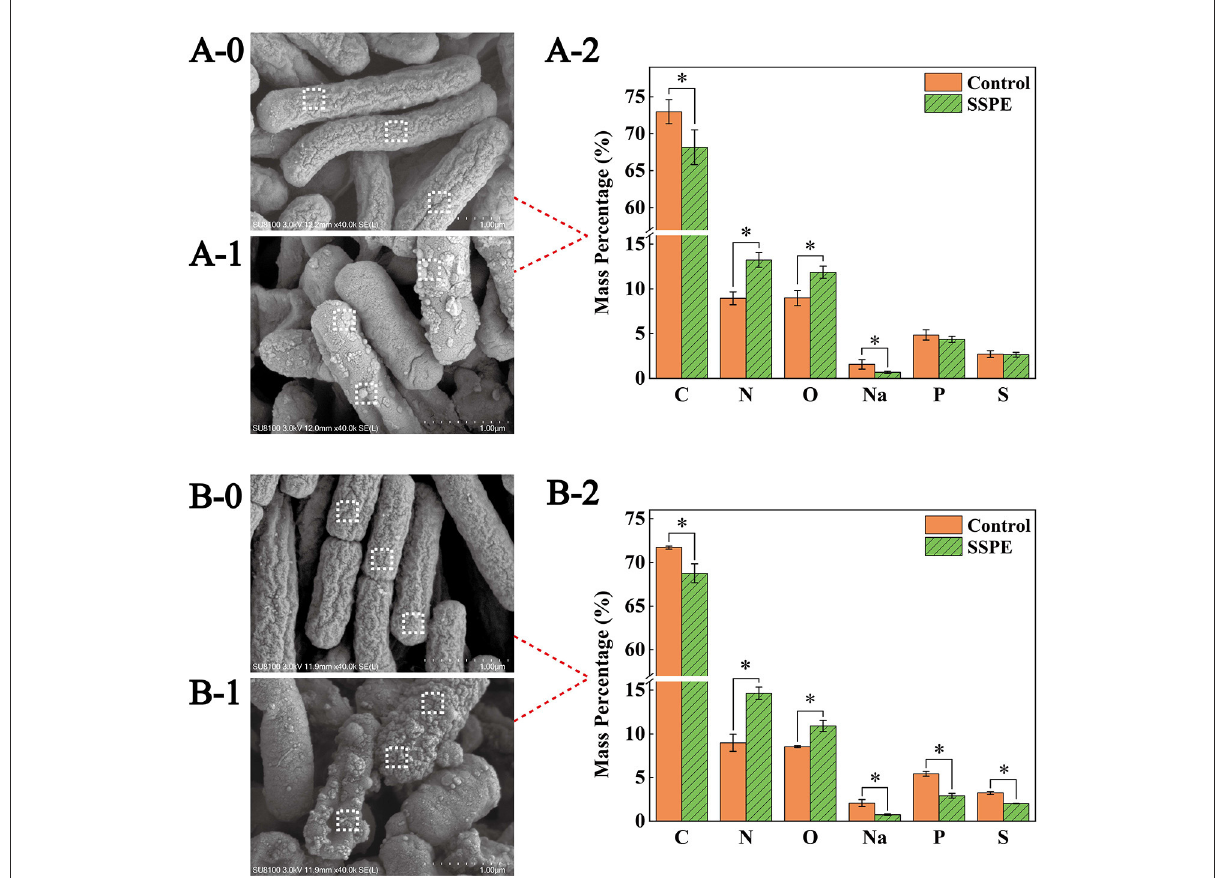
FIGURE3 SEM and EDS graphs of E. coli under different treatment conditions. Graphs A and B are the SEM and EDS graphs of E. coli cultured for 6 and 12h, respectively. (A-0) E. coli cultured for 6h without SSPE treatment, (A-1) E. coli cultured with 1 mg/mL SSPE for 6h, (B-0) E. coli cultured for 12h without SSPE treatment, (B-1) E. coli cultured with 1 mg/mL SSPE for 12h. (A-2,B-2) represent the EDS-based spot scanning elemental composition analysis graphs of E. coli cultured for 6 and 12h, respectively. Control: without SSPE treatment. SSPE: treated with 1 mg/mL SSPE. Dotted box denotes the area selected through EDS spot scanning. *indicates significant difference between treatment group and untreated group in element content ( p <